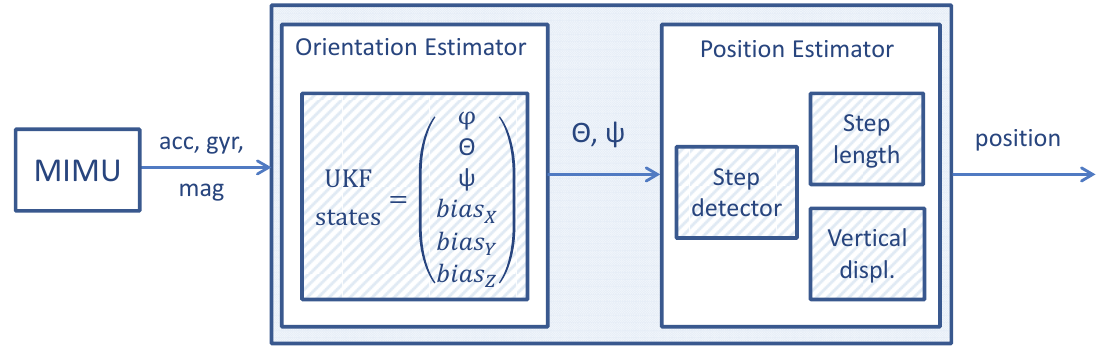
Figure 1. Overview of the structure of the inertial pocket navigation